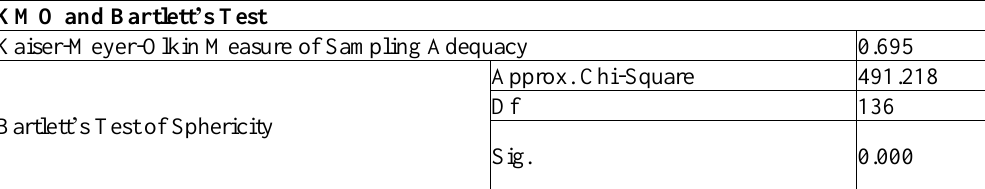
Table 6. KMO and Bartlett’s Test on the Factors Influencing Adoption of Building Commissioning Practices (developed by the authors) KMO and Bartlett’s